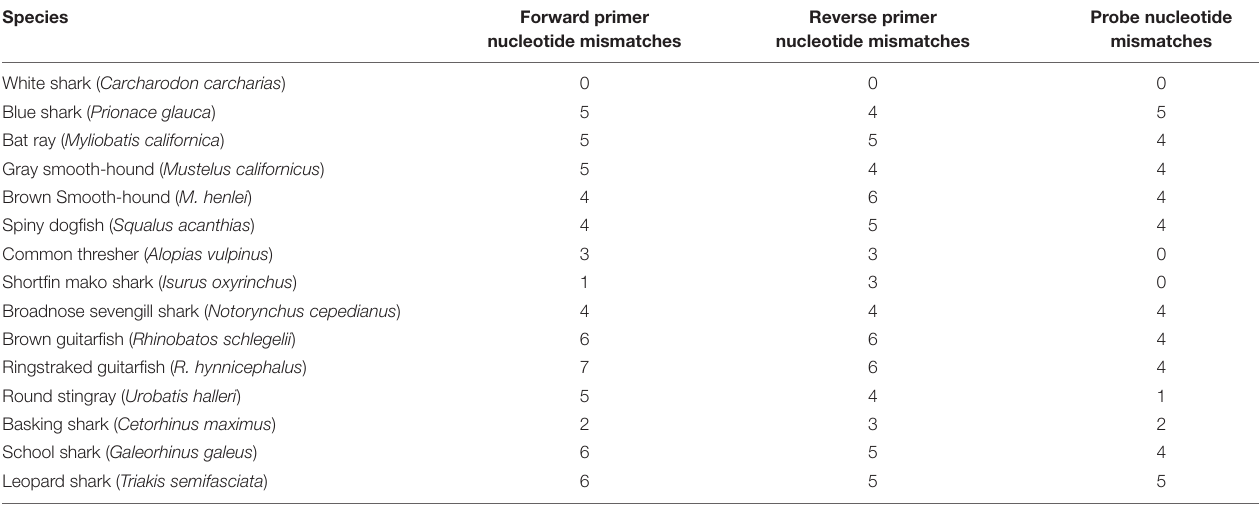
Reverse primer Probe nucleotide nucleotide mismatches nucleotide mismatches mismatches